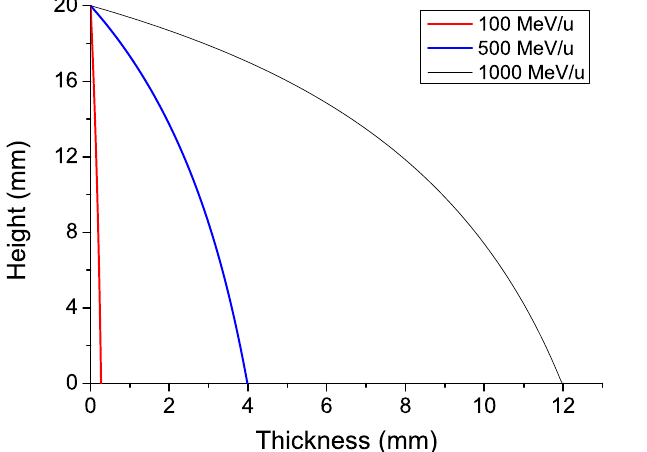
geometries.FIG. 6. Simulation results of the compression ratios at the target for different (sweep/spot radius) ratios at the wedge. They can be compared with the straight line which denotes y ¼ x